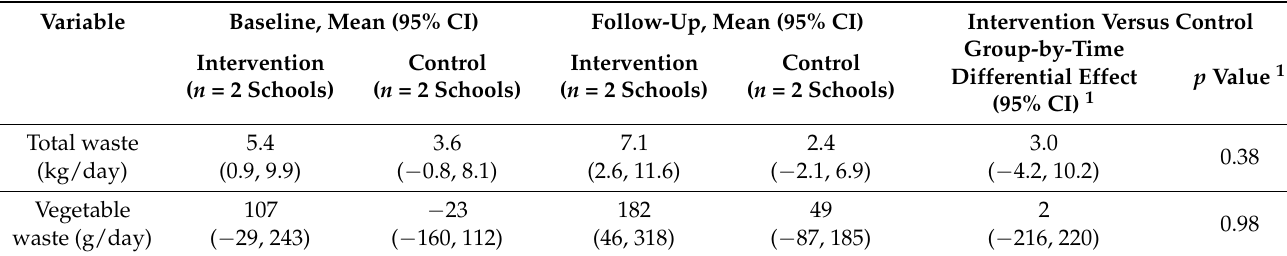
Table 3. Secondary outcome of student vegetable waste in the baseline and follow-up period for schools who either implemented the multi-strategy behavioral intervention (intervention schools) or continued to offer their regular canteen menu (control